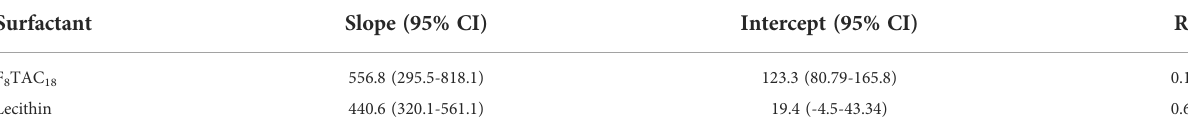
TABLE 2 MR-ARFI simple linear regression fi tting along with con fi dence intervals (95% CI) of the data points in Figure 4B .